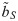
Precision of parameter estimates in the HBMi.For each of the 61 parameter constellations estimated from the sample data set, 1000 simulations were performed with the HBMi. (A) and (B): log(median(REs)) of the border parameters bS, bU, b˜S, b˜U, and log(median(AEs)) of the drift parameters νS*, νU*, νB* with T = 1200s (A) and T = 3600s (B). (C) and (D) log(median(REs)) for the derived model parameters μS*, σS*, μU*, σU* and log(median(AEs)) for the parameters pSS* and pUU* for T = 1200s (C) and T = 3600s (D). Parameter combinations with mean errors < 0.25 across all variables plotted in black.